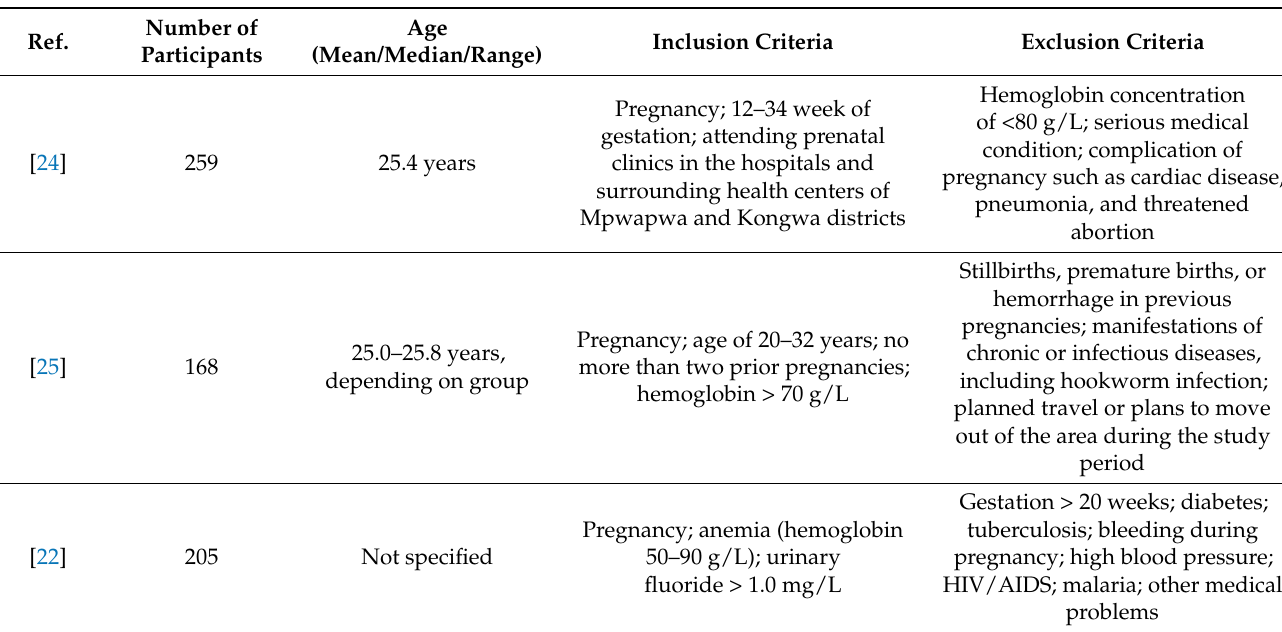
Table 4. The characteristics of the participants of the randomized controlled trials included in the systematic review